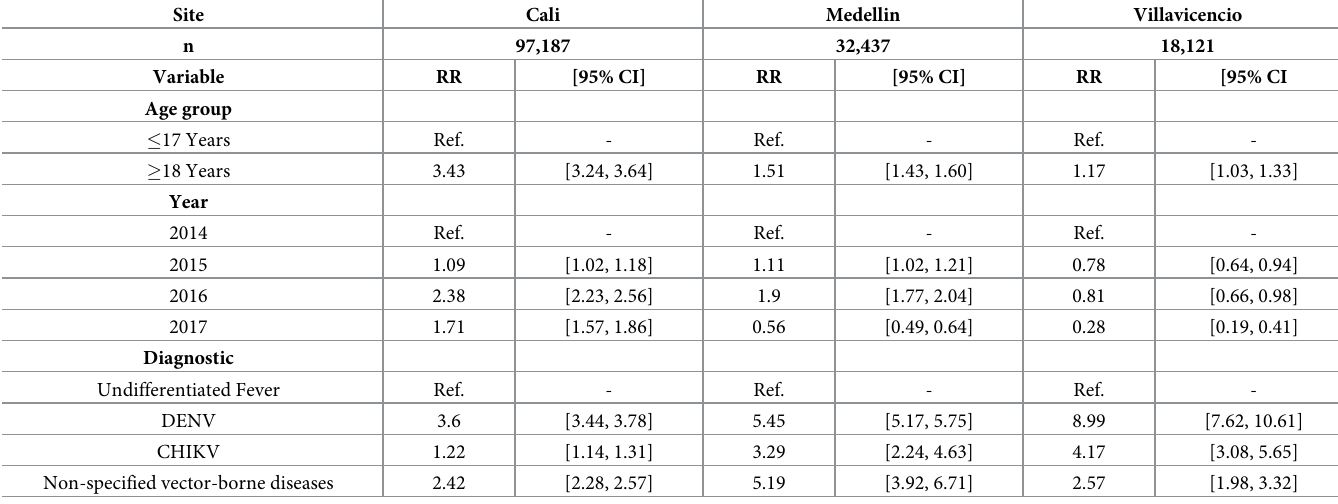
Table 3. Factors associated to reporting of arboviral diseases in Cali, Medellin, and Villavicencio,